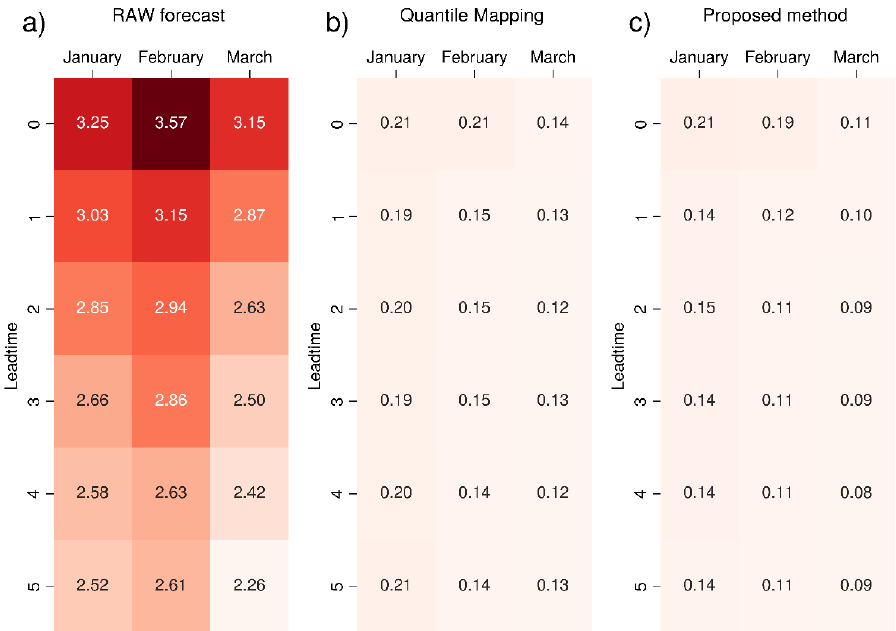
Figure 4. RMSE (in K) of the 2 m mean temperature 99th percentile value for seasonal forecast GCFS2.1 (DWD) compared to ERA5 reanalysis: ( a ) raw data, ( b ) data corrected with standard quantile mapping and ( c ) corrected with the proposed bias correction method. The colour scale ranges from white (RMSE = 0) to dark red, increasing in intensity as the metric increases. The most intense colour corresponds to the maximum value.